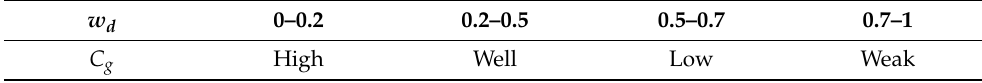
Table 1. Relationship between the values of w d and C g